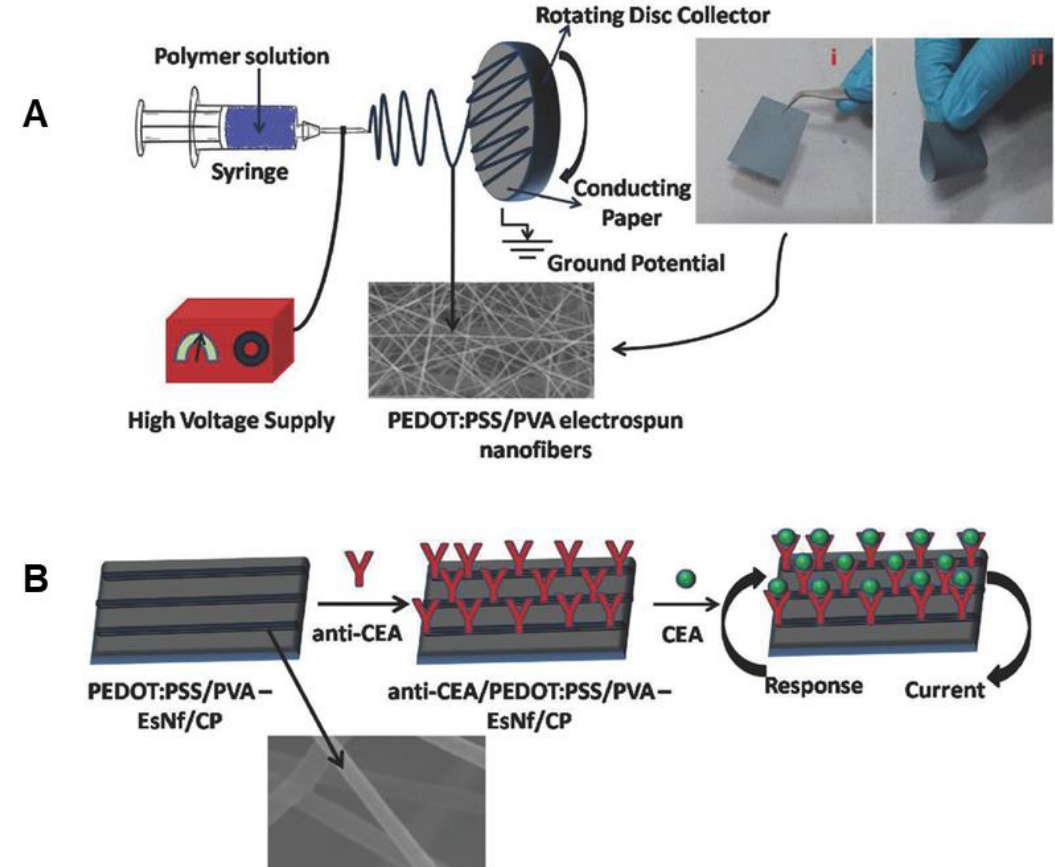
Figure 22. Biosensor developed from PEDOT:PSS/PVA to detect carcinoembryonic antigen (CEA) [230]: ( A ) diagram of electrospinning setup of PEDOT:PSS/PVA nanofibers; ( B ) schematic diagram of PEDOT:PSS/PVA-electrospun nanofibers/conducting paper and immobilization of CEA antigen. Reprinted from [230]. Copyright 2016, John Wiley & Sons.